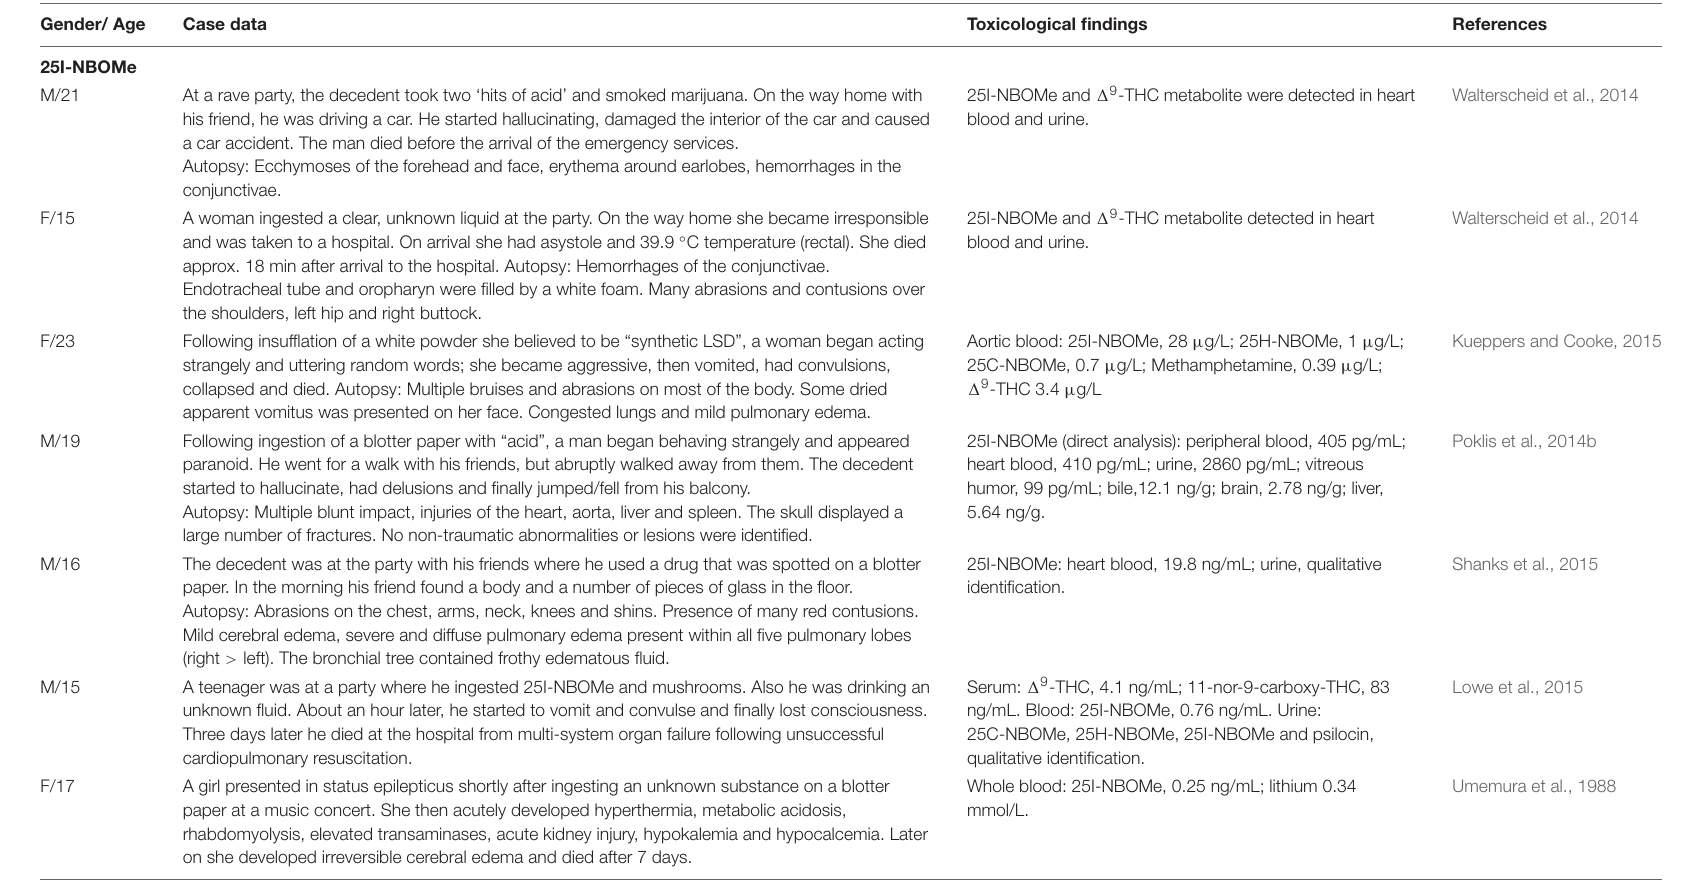
TABLE 2 | Fatal cases related to use of NBOMe